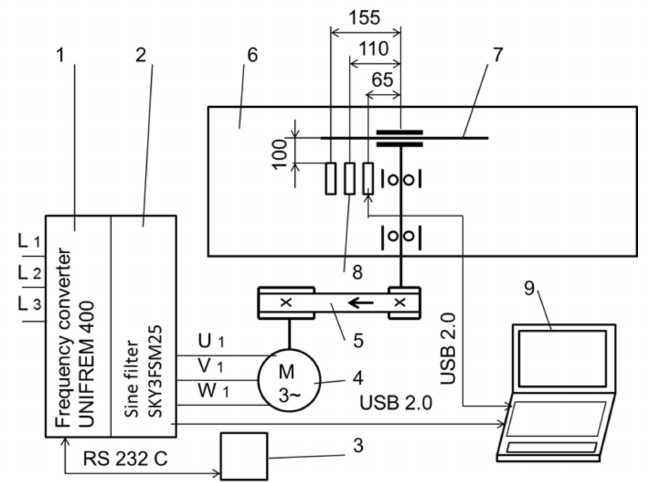
Figure 8. Scheme of a circular saw, including a device for measuring the cutting power and the surface temperature of the circular saw blade.